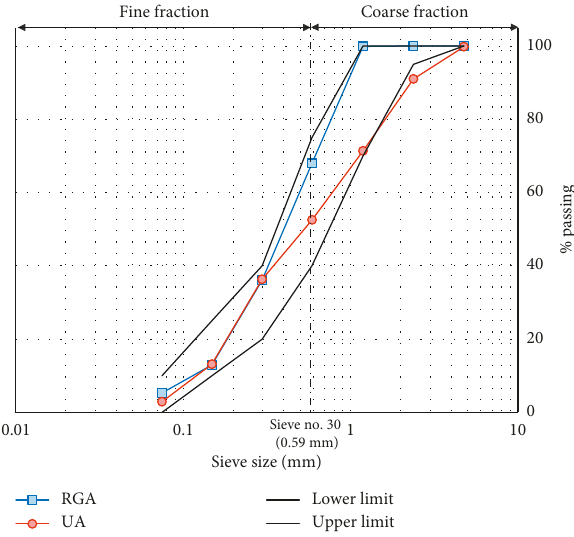
Figure 1: Granulometric distribution